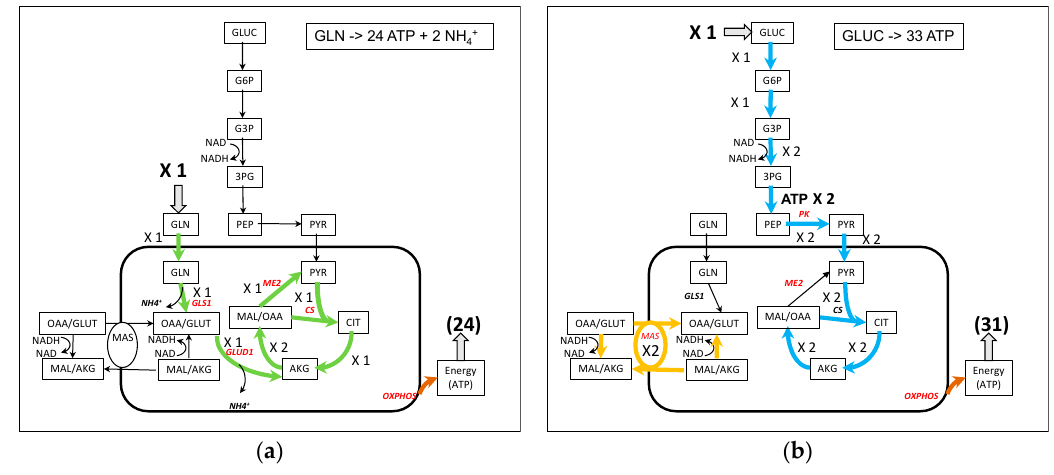
Figure 2. A simplified representation of ATP synthesis from glutamine ( a ) and glucose ( b ). Note that in ( b ), for the sake of simplicity, the representation of MAS has been separated from the TCA cycle although they share the MDH2 activity with a net flux of 4, 2 for MAS and 2 for the TCA cycle. The complete figures of the fluxes are in Figure S2.